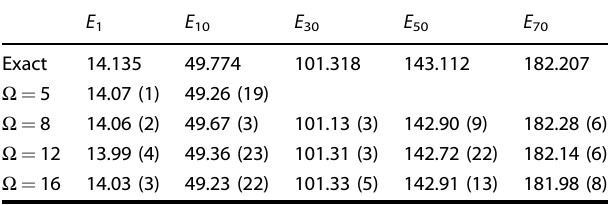
Table 1. Comparison of the experimentally measured Riemann zeros with the true values for different driving